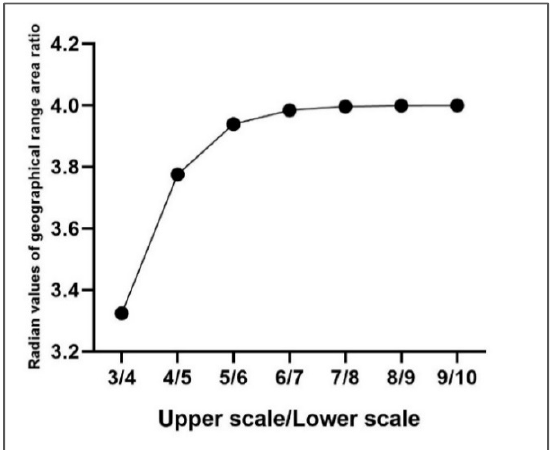
Figure 10. The horizontal axis represents Upper scale divided by Lower scale, and the vertical axis represents the radian values of geographical range area ratio. Table 3. Corresponding table of map scale and value of map load.